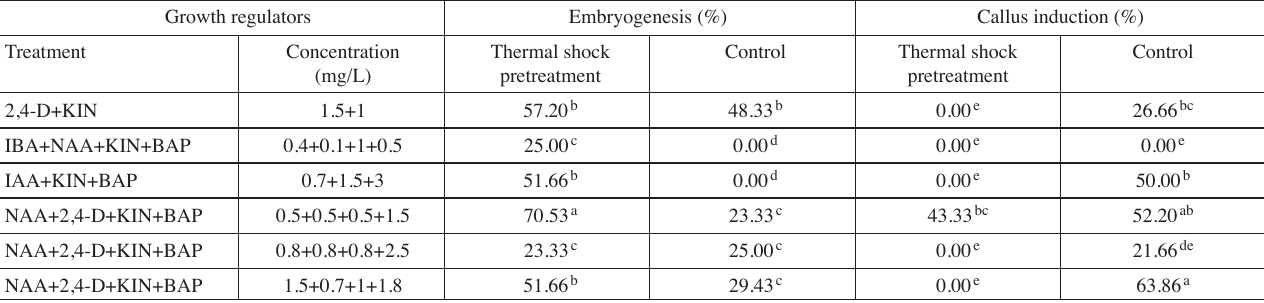
Tab. 2: Effects of thermal pretreatment and different hormonal combinations on embryogenesis and callus induction in experiment 1. Growth